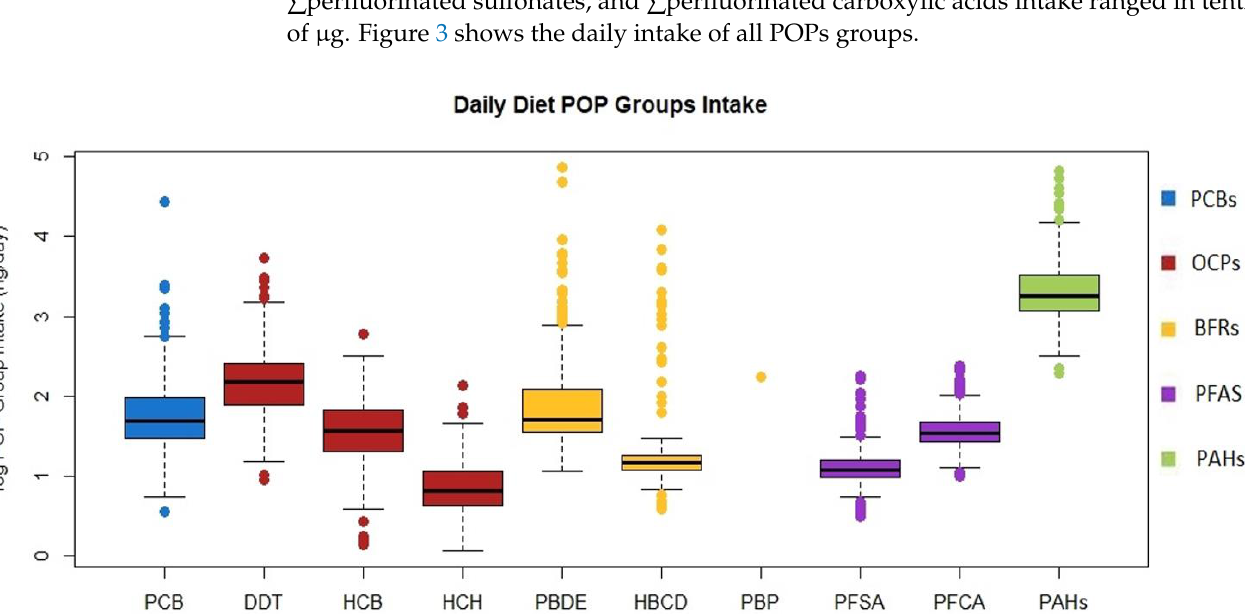
PCB 138 (<0.003 to 4.27/0.014), PCB 153 (<0.003 to 5.56/0.018), and PCB 180 (<0.003 to 2.92/0.009). The remaining PCBs were detected at very low concentrations in less than 30% of samples. The sum of six NDL-PCBs ranged between <0.005 and 13.0 ng/g ww with a median of 0.044 ng/g ww. Selected OCPs were found in the same range of concentrations compared to PCBs. HCB, p,p’ -DDT, and its metabolites (p,p’ - DDE and p,p’ -DDD) were found in more than 50% of samples, specifically 98%, 53%, 99%, and 79%, respectively. The highest amounts were observed for p,p’ -DDE (<0.003 to 3.96/0.133) followed by HCB (0.003 – 0.609/0.038), p,p’ -DDD (<0.003 to 0.347/0.007), and p,p’ -DDT (<0.005 to 1.03/0.006). The total of DDTs was <0.005 to 5.43 with a median of 0.160 ng/g ww. Slightly lower concentrations compared to the two aforementioned groups of POPs were observed for the analyzed BFRs, where only PBDE congeners 47 and 99 were found in a significant portion of samples, i.e., 64% and 76%. BDE 47 was found in the amounts <0.003 to 0.762/0.005 and BDE 99 <0.003 to 1.76/0.012. The total of all analyzed PBDEs (n = 20) was in the range <0.05 to 50.3 ng/g ww. It should be noted that the outlier maximum value belonged to PBDE 209, which was the only congener found in this sample, and the total detection frequency of PBDE 209 was 7%. The concentration of PFAS as well as their detection frequencies were generally very low. The two predominant compounds from this group were PFOA (<0.006 to 0.117 ng/g ww) and PFOS (<0.006 to 0.301), which were detected in 16% and 9%, respectively. The remaining PFAS were detected in only 1 – 5% of samples, or they were not detected at all. The last group of analyzed pollutants was PAHs, specifically the lighter ones, e.g., ACE, PHE, FLT, and PYR, which belonged to the highest measured. All of the 3 – 4 ring PAHs were detected in more than 60% of samples and their concentrations were one order of magnitude higher than those of PCBs and OCPs, e.g., PHE (<0.05 to 14.3/0.639), PYR (<0.05 to 25.8/0.178), FLT (<0.05 to 11.4/0.153), and ACE (<0.05 to 3.58/0.081). These PAHs comprised relatively more than 70% of all PAHs. The carcinogenic BaP was detected in